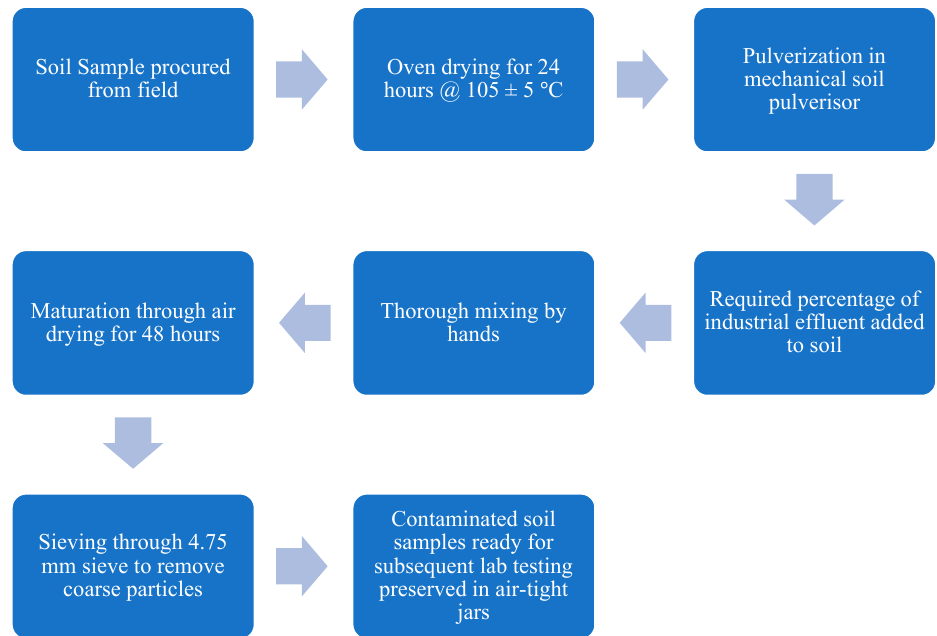
Figure 5. Flow-chart presenting specimen preparation procedure.